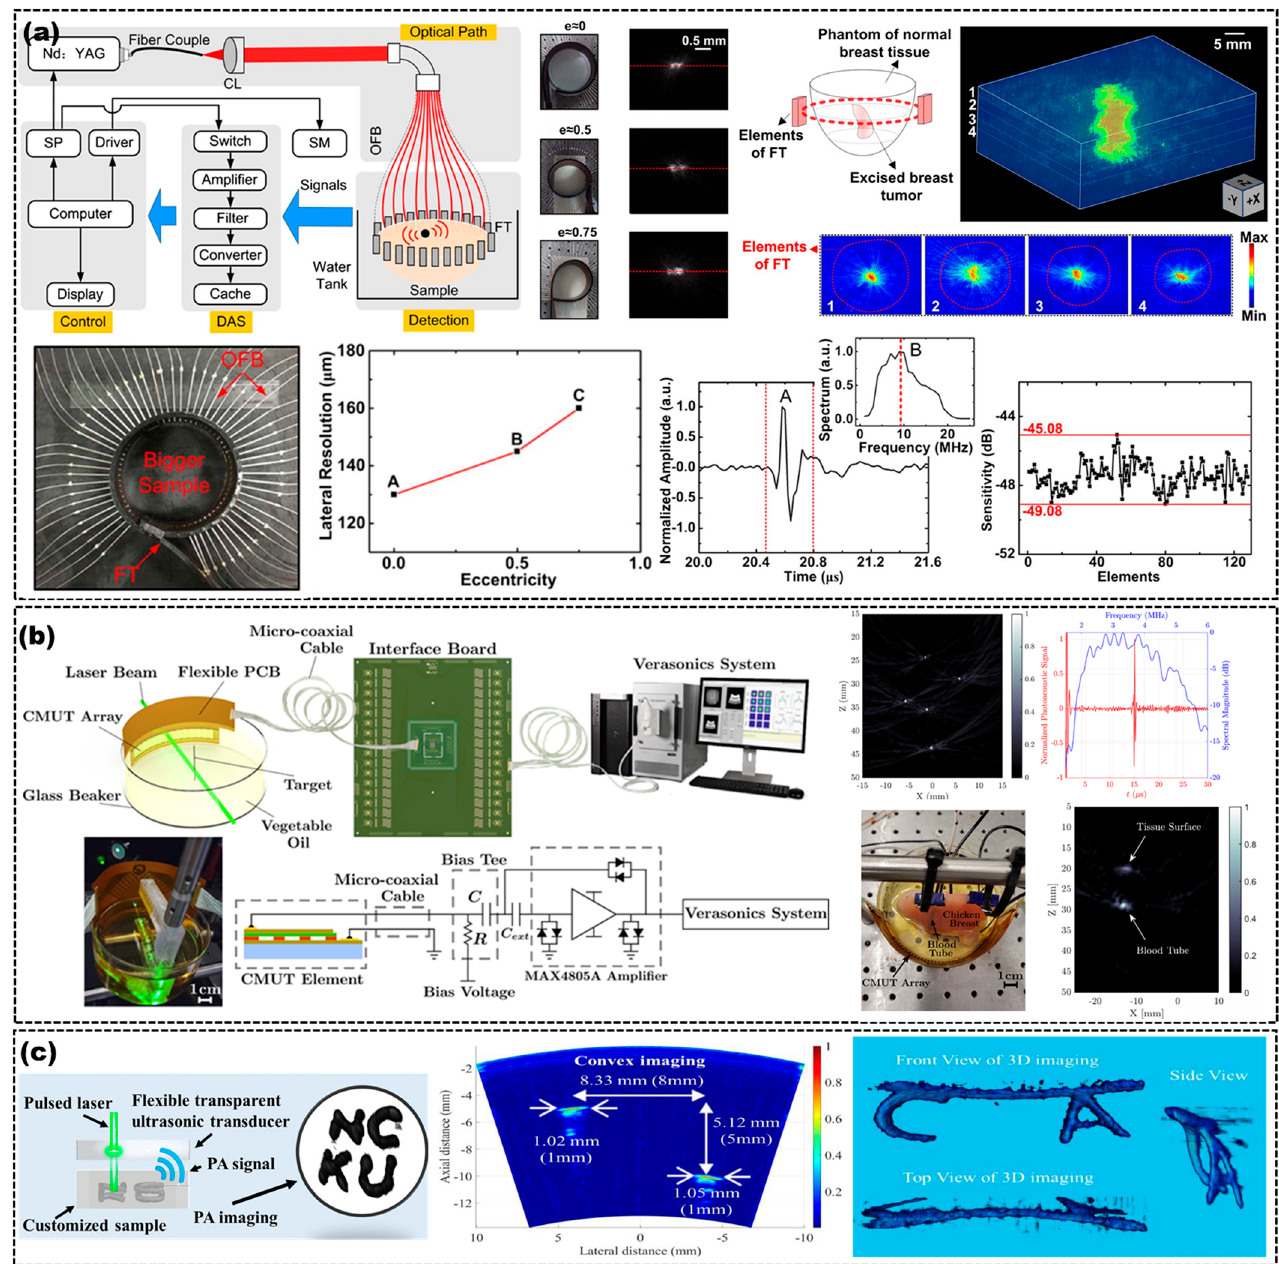
Figure 9. ( a ) Schematic of PAI based on a flexible US array ( top left ), performance characterization of a flexible US transducer ( bottom right ), PA images with different bending US arrays of two truncated hairs ( top middle ), variation between the resolution and the degree of eccentricity of the US array (bottom middle), PA images of breast tumor ( top right ) and optical images of a flexible US array with OFB ( bottom left ). CL, collimating lens; SP, synchronization pulse; SM, stepper motor; OFBs, optical fiber bundles; DAS, data acquisition system. Adapted from [65]. ( b ) Experimental setup for the PAI system ( left ), PA images of wire targets ( top middle ), frequency spectrum of a CMUT in PAI ( top right ), a photo and PA images of chicken breast (middle right). Adapted from [15]. ( c ) Schematic of the PAI system with a flexible US transducer based on PVDF ( left ) and PA images of different objects from different perspectives ( middle and right ). Adapted from [26].